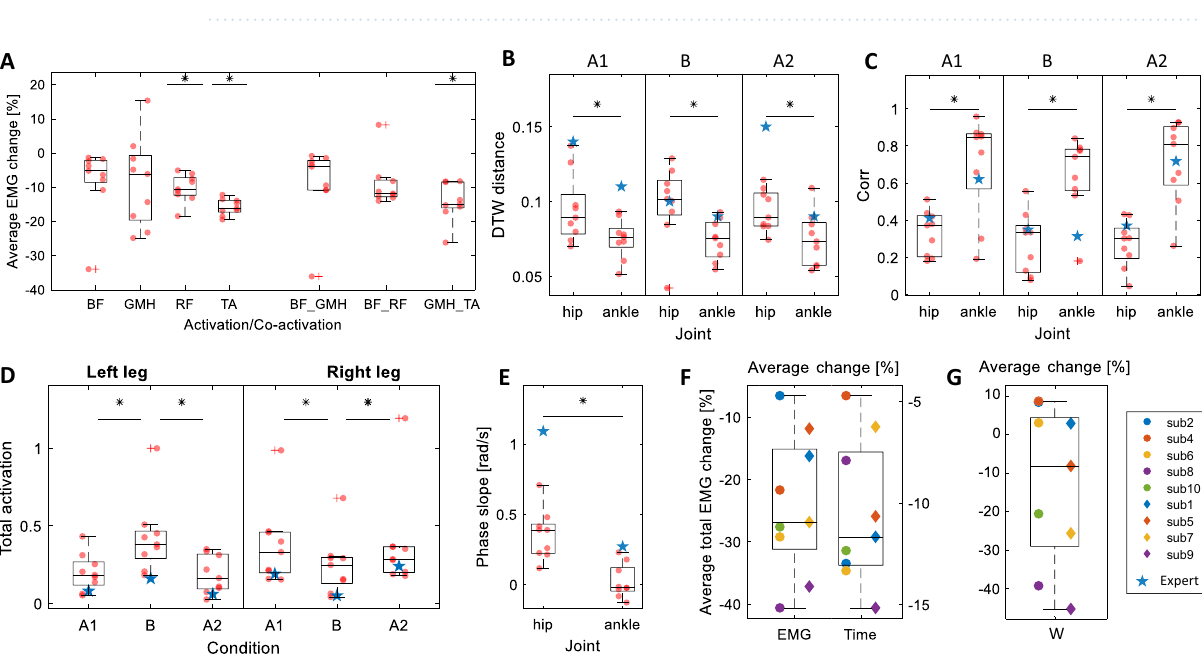
Figure 5. ( A ) Average relative change ( (cid:31) C m ) for each activation and co-activation across participants. It shows the average reduction per condition relative to the average value. For example, if the mean activation of a muscle is 0.5, a (cid:31) C of − 10 % means that its activation has dropped about 0.05 in each condition on average. ( B ) Comparison of average estimated values of the DTW distance for the hip and ankle joints from the foot angle across participants in three conditions. ( C ) Comparison of foot and the ankle and hip joints maximum cross- correlation across participants in three conditions. ( D ) Average total muscle activation in each condition and leg across participants. ( E ) Comparison of estimated phase slopes for the hip and ankle joints (the rate of phase change over sample time) across participants. ( F ) Comparison of the average relative change for trial elapse time ( (cid:31) T m ) and the total muscle activation ( (cid:31) C m Total ) across participants. ( G ) average relative change of system energy ( (cid:31) W m ) across